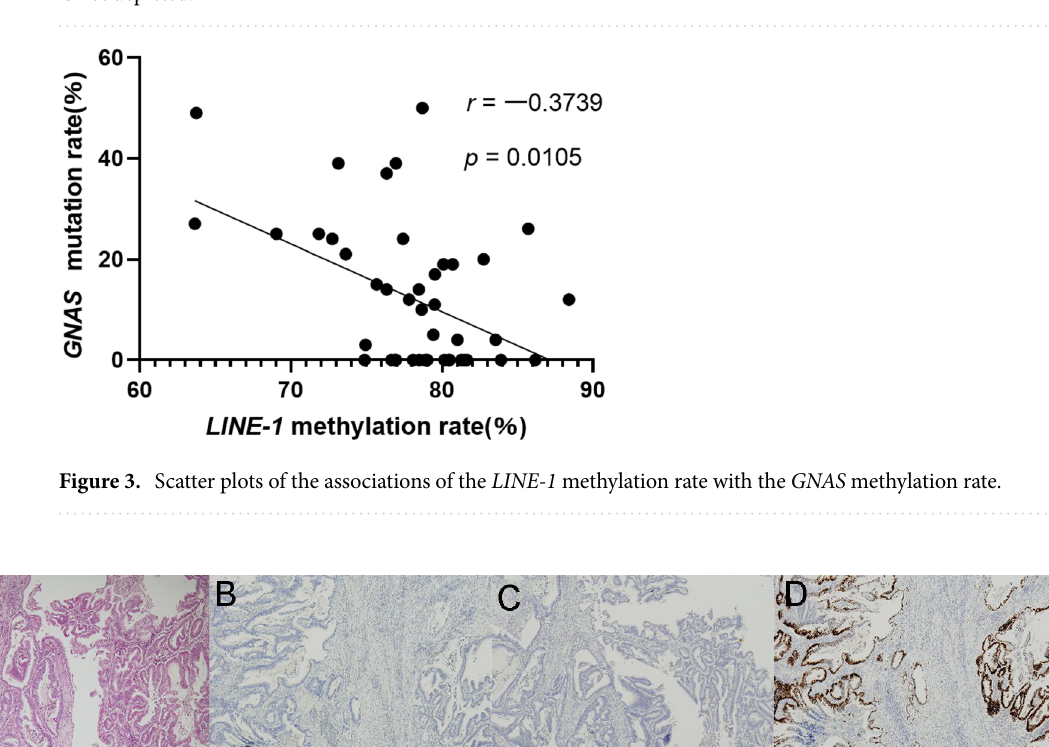
Figure 2. Heat map visualization of the results of pyrosequencing and IHC analyses. White cells, negative expression. Red or brown cells, positive expression. Because of the undetermined threshold, LINE-1 methylation is not depicted.